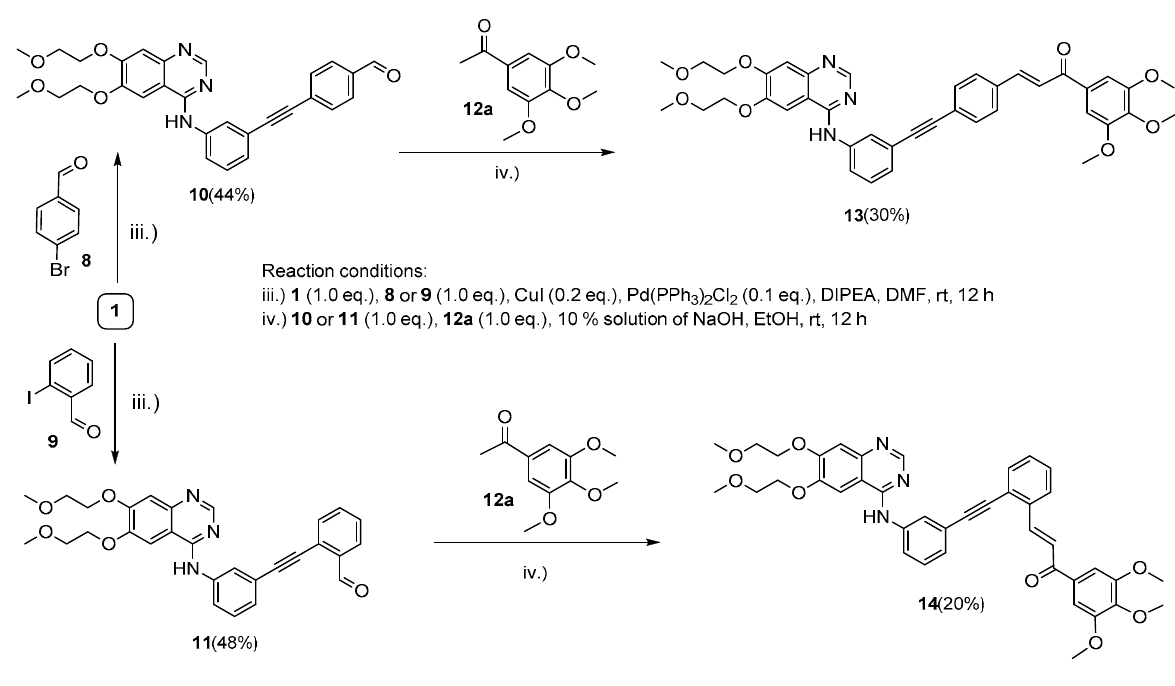
Scheme 2. Synthesis of the group of erlotinib–chalcone hybrids with alkyne